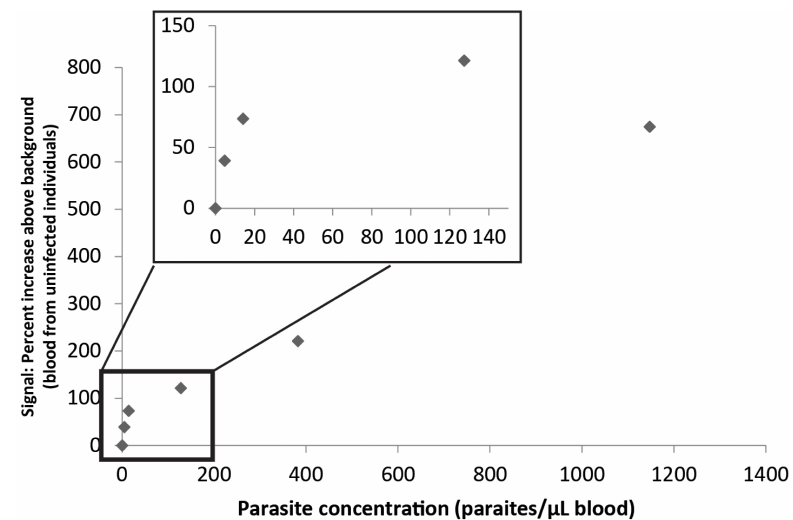
Figure 2. Test of substrate S5 ' -fluor using purified enzymes. ( a ) S5'-flour immobilized on a microscopy slide was incubated with pfTopoI. A subsequent urea wash removes unreacted fluorescent tails prior to fluorescence microscopic analysis. ( b ) S5'-fluor was incubated with no enzyme hTopoI, or pfTopoI, as indicated and the results analyzed in a fluorescent microscope. The results are shown as the percent increase in fluorescent signal compared to the sample without enzyme. The graph shows the average of three independent experiments.